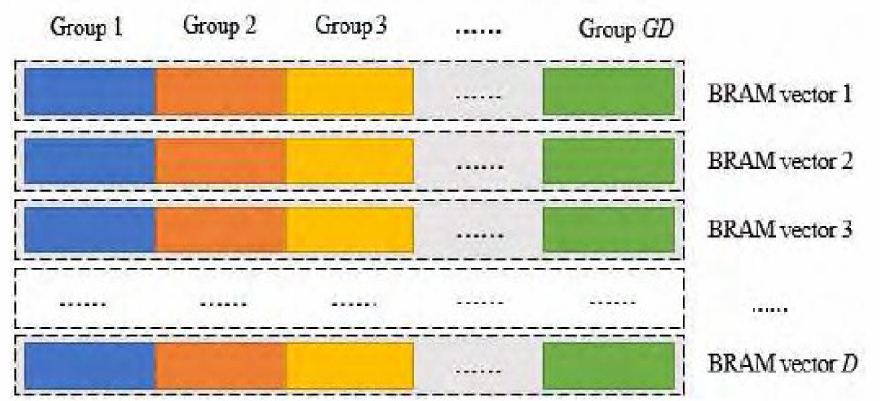
Figure 15. Pattern for BRAMs [50] (Reprinted with permission from ref. [50]. Copyright 2021